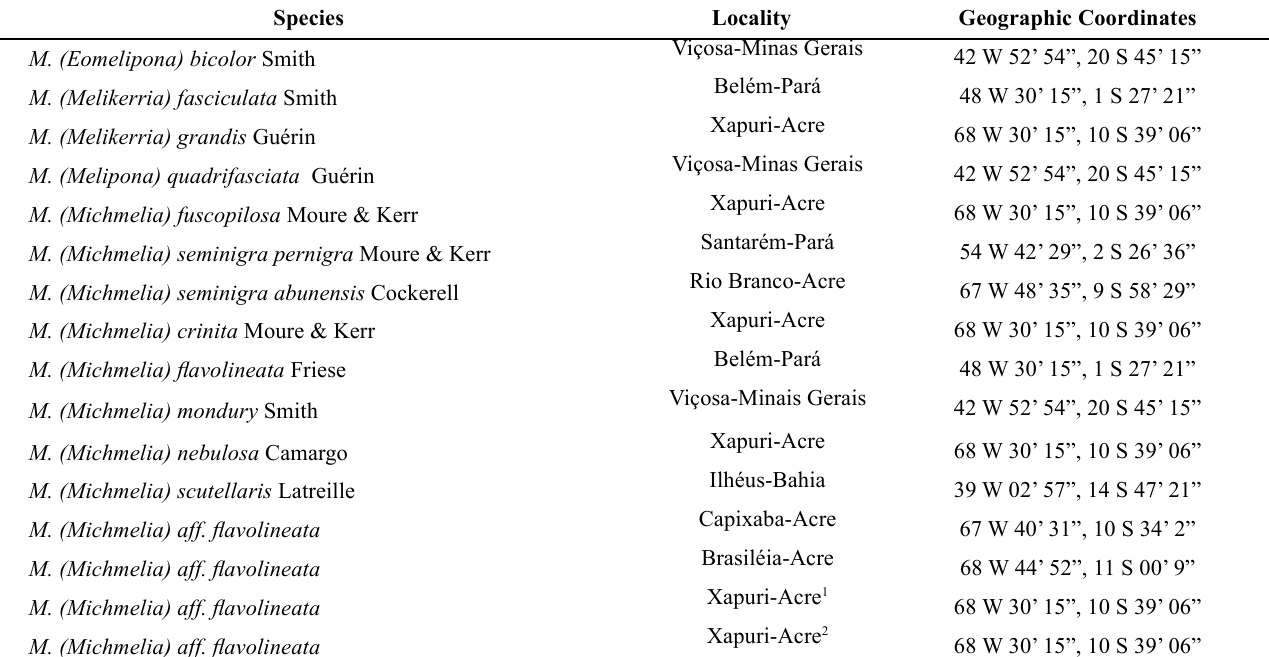
Table 1 Melipona species analyzed and collection